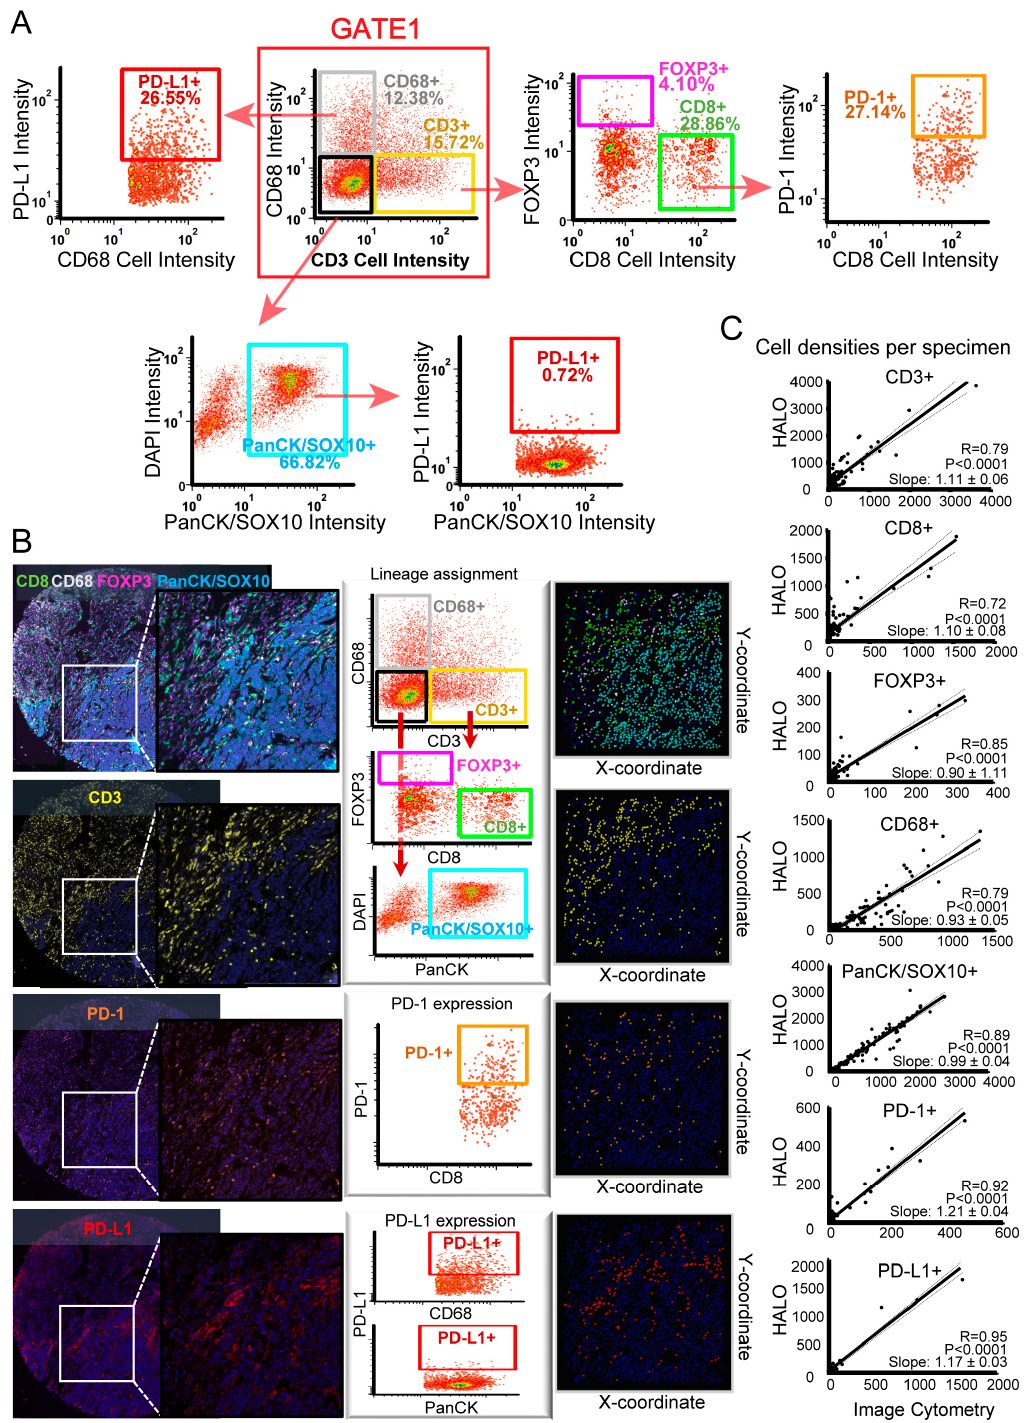
Figure 3. Quantitative evaluation of all parameters by image cytometry. ( A ) Image cytometry gating strategy to define the cell phenotypes. ( B ) The data were visualized after manual gating and validating the image cytometry quantification. Representative image of a TMA from a FFPE PDAC core stained by mIHC (left), with corresponding image cytometry gates (middle), and a color-coded dot plot map of the gated populations (right). ( C ) The cell densities were identified by our image cytometry gating strategies; those image cytometry methods showed robust correlation with previous ones using the HALO platform (the current standard procedure). The linear regression and the 95% confidence interval for the slope are displayed.